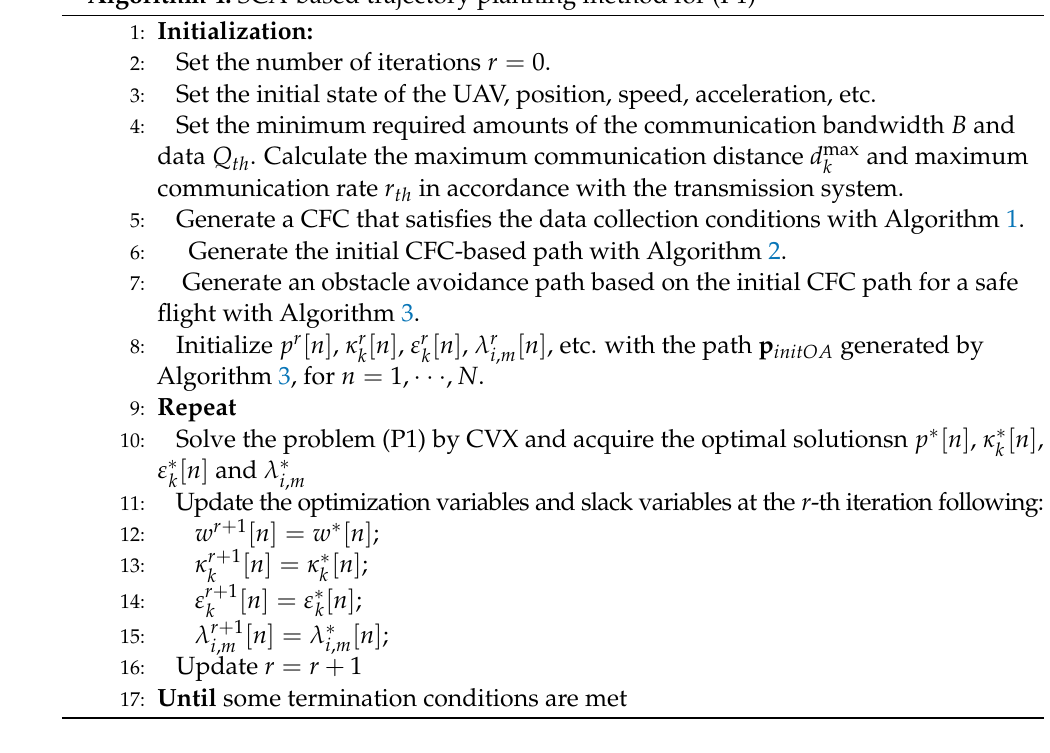
Algorithm 4: SCA-based trajectory planning method for (P1)